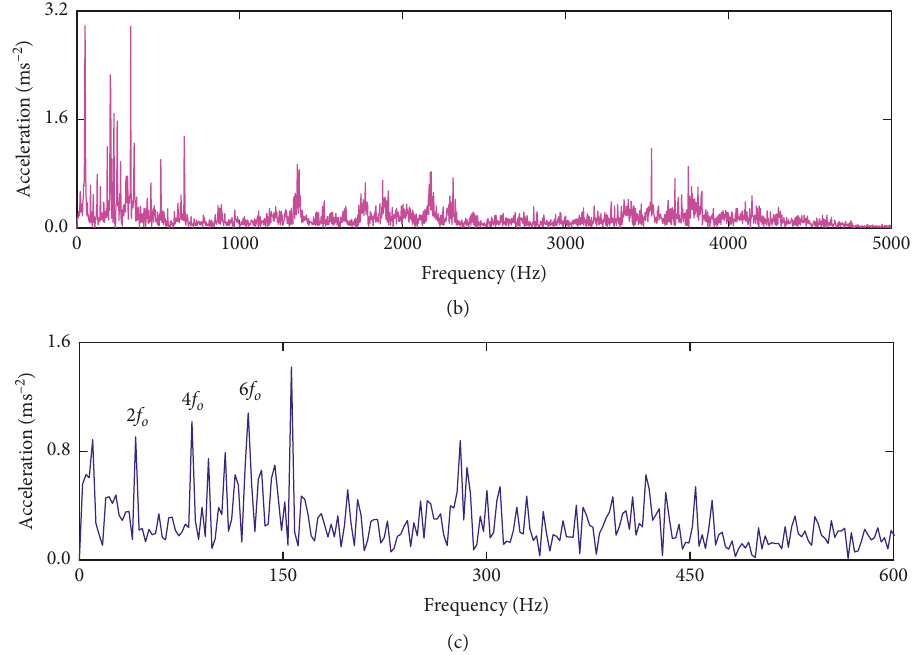
Figure 33: Measured vibration signals: (a) original signal; (b) Fourier spectra of (a); (c) envelope spectra of (a).